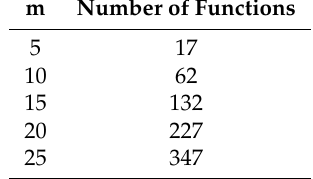
Table 1. Equivalence of number of basis function compared to degree of basis expansion for both Problems #1 and #2. m Number of